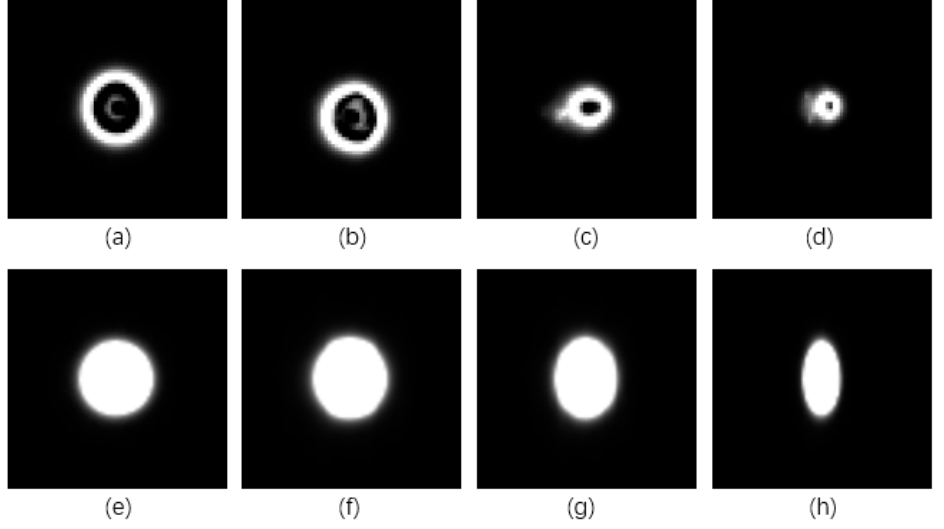
Figure 2. Near infrared (NIR) markers imaged from different angles. ( a ) Traditional marker imaging result from 0°. ( b ) Traditional marker imaging result from 20°. ( c ) Traditional marker imaging result from 40°. ( d ) Traditional marker imaging result from 60°. ( e ) Designed marker imaging result from 0°. ( f ) Designed marker imaging result from 20°. ( g ) Designed marker imaging result from 40°. ( h ) Designed marker imaging result from 60°.